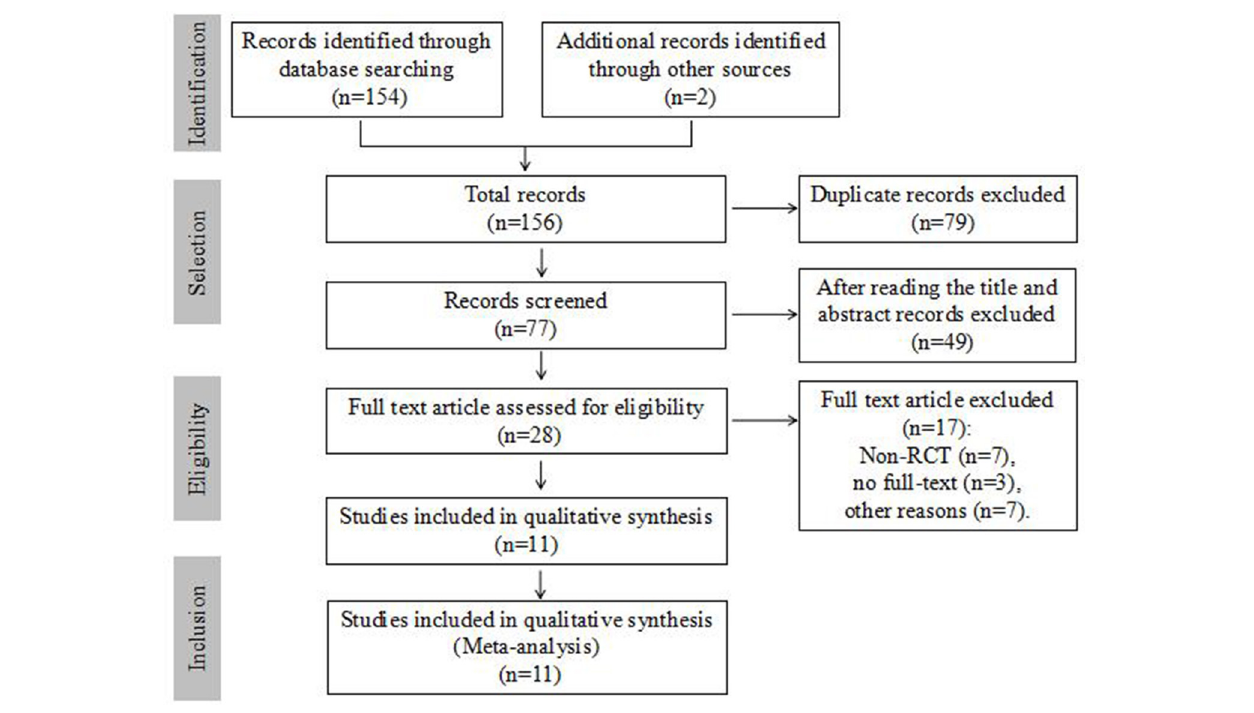
FIGURE 1 | Flow diagram of study